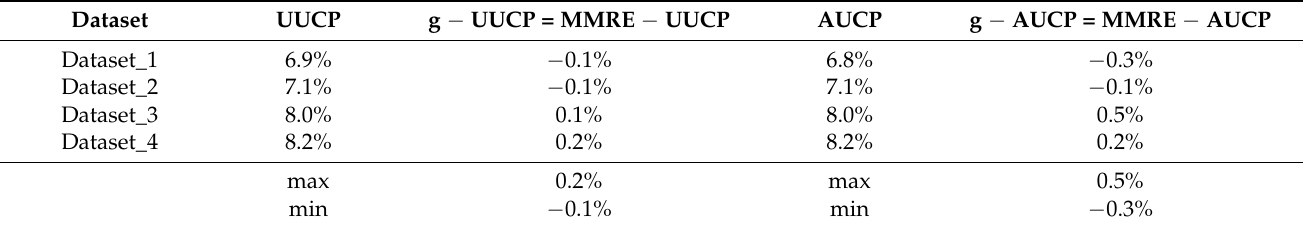
Table 11. Influence of dependent variables (UUCP and AUCP) on the change in the MMRE value.